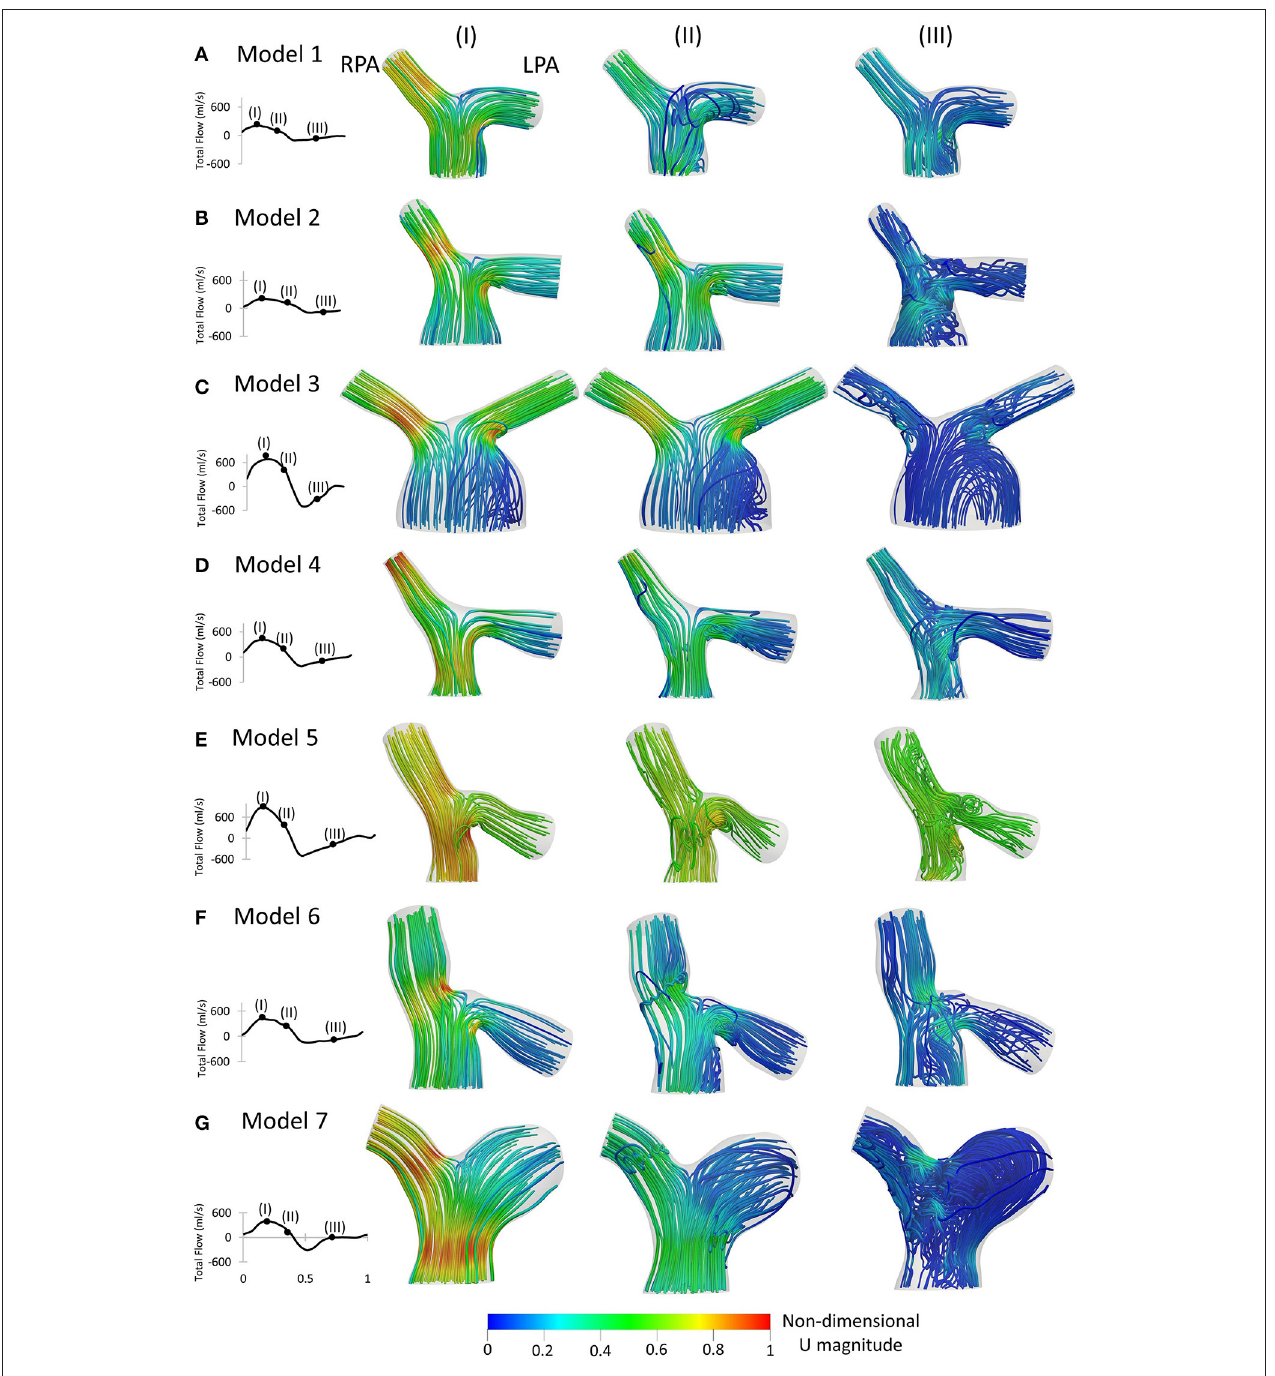
FIGURE 7 | Left to Right: Patient-specific flow waveforms and velocity streamlines at (I) peak flow; (II) mid deceleration at systole; and (III) mid diastole, for (A) Model 1; (B) Model 2; (C) Model 3; (D) Model 4; (E) Model 5; (F) Model 6; and (G) Model 7. Streamlines are colored by non-dimensionalized velocity magnitude based on the maximum velocity during the cardiac cycle of each patient. The RPA and the LPA branches are indicated in model 1.